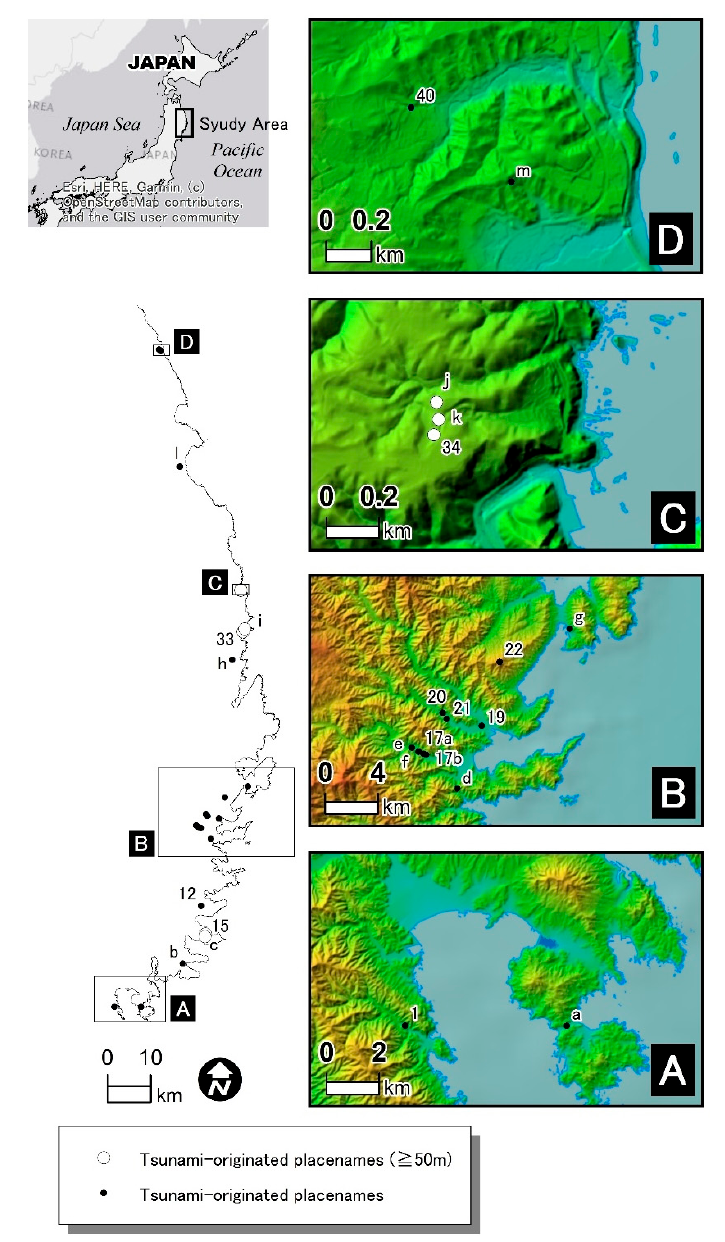
Figure 1. Map of tsunami-originated placenames. IDs in the map correspond to those in the list of placenames in Table 1. Empty dots are placenames with altitudes above 50 m.